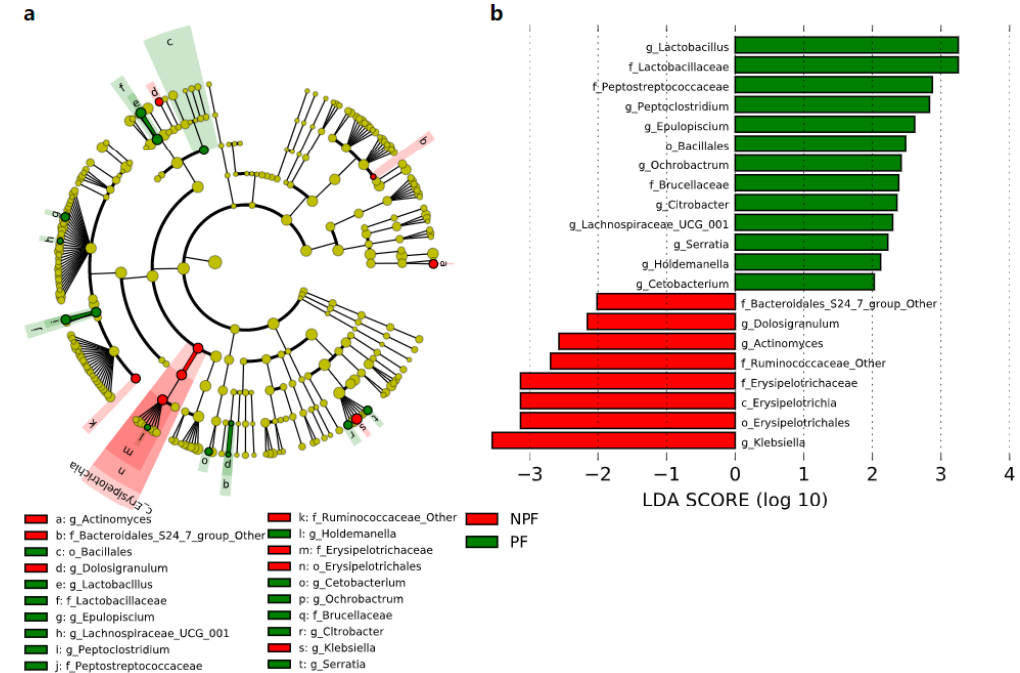
Figure 5. Differential bacterial taxa between the NPF and PF groups at week 6 revealed by LDA cladogram ( a ) and ranking ( b ). Only taxa with an LDA score threshold larger than 2 are shown. LEfSe, linear discriminant analysis of effect size; LDA, linear discriminant analysis; PF, probiotics formula; NPF, non-probiotics formula; p, phylum; c, class; f, family; o, order; g, genus.